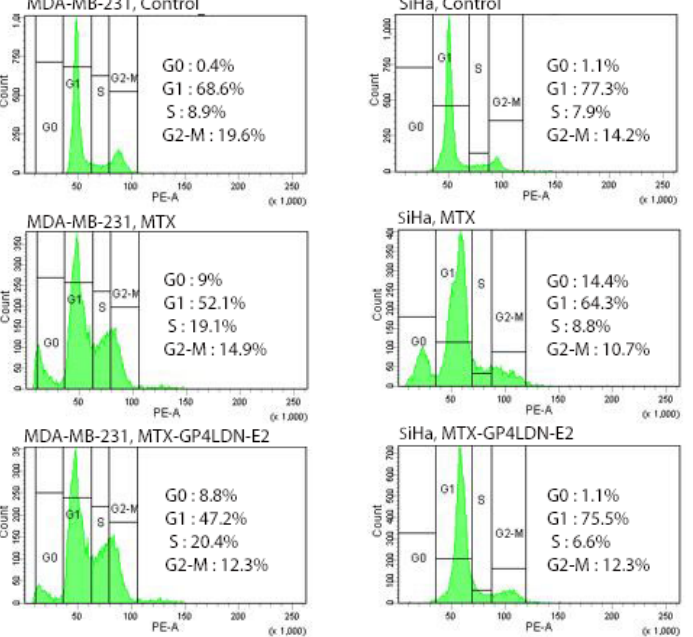
Figure 8. Cell cycle and cell death analysis by FACS in MDA-MB-231(EGFR overexpressed) and SiHa (EGFR negative) cells after 24 h incubation with MTX and MTX–G–P 4 LDN–E2. (EGFR negative) cells after 24 h incubation with MTX and MTX–G–P 4